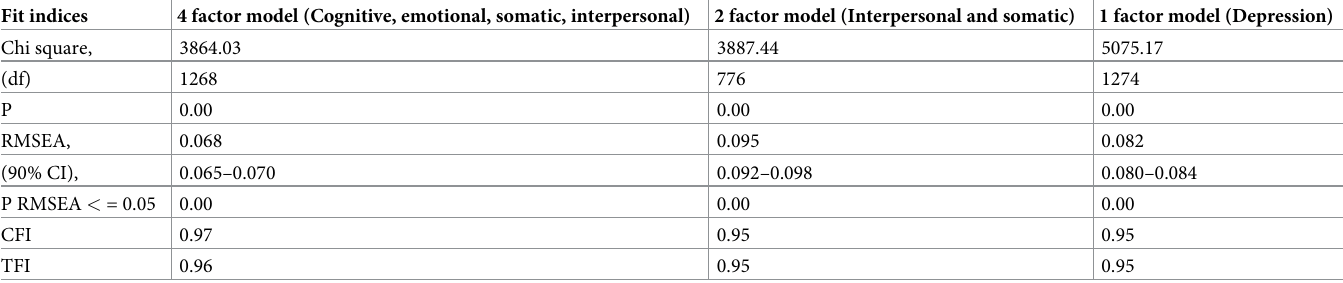
Table 2. Confirmatory factor analysis model fit